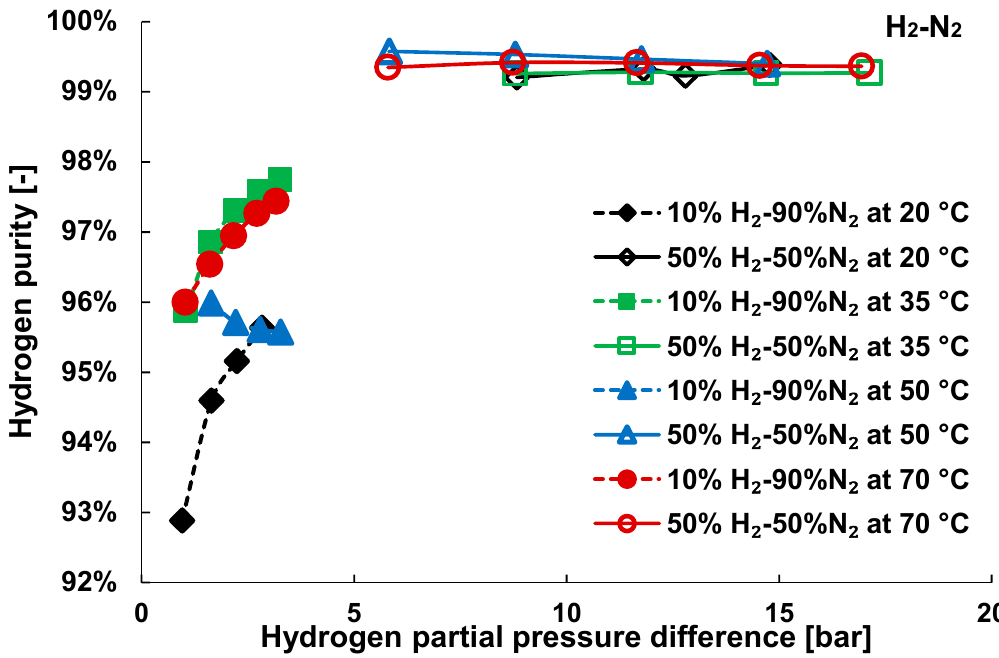
Figure 14. Comparison between hydrogen purity in an H 2 -N 2 mixture with 10% and 50% hydrogen concentration at 20, 35, 50 and 70 °C, for CMSM-550.